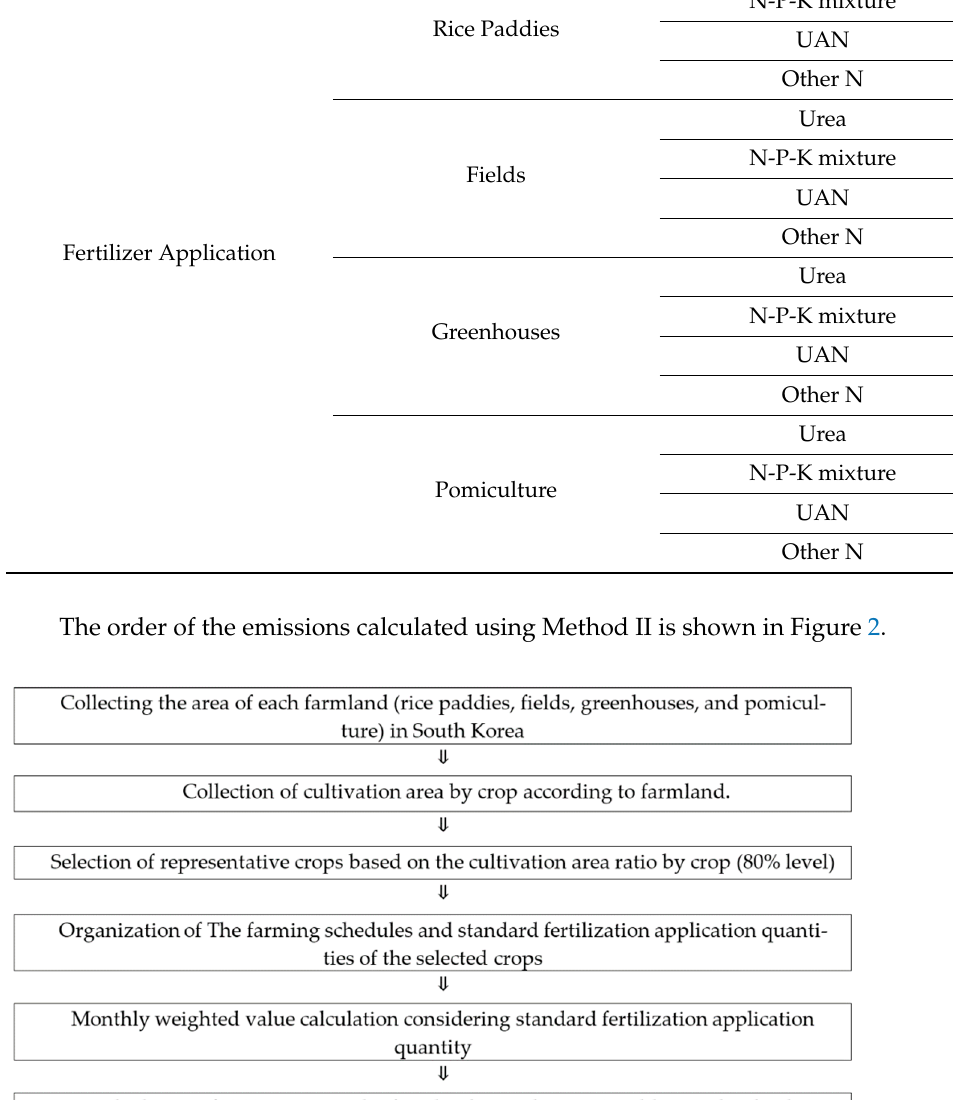
Table 5. The classification system of fertilizer-use agricultural land emission sources considering Method II.